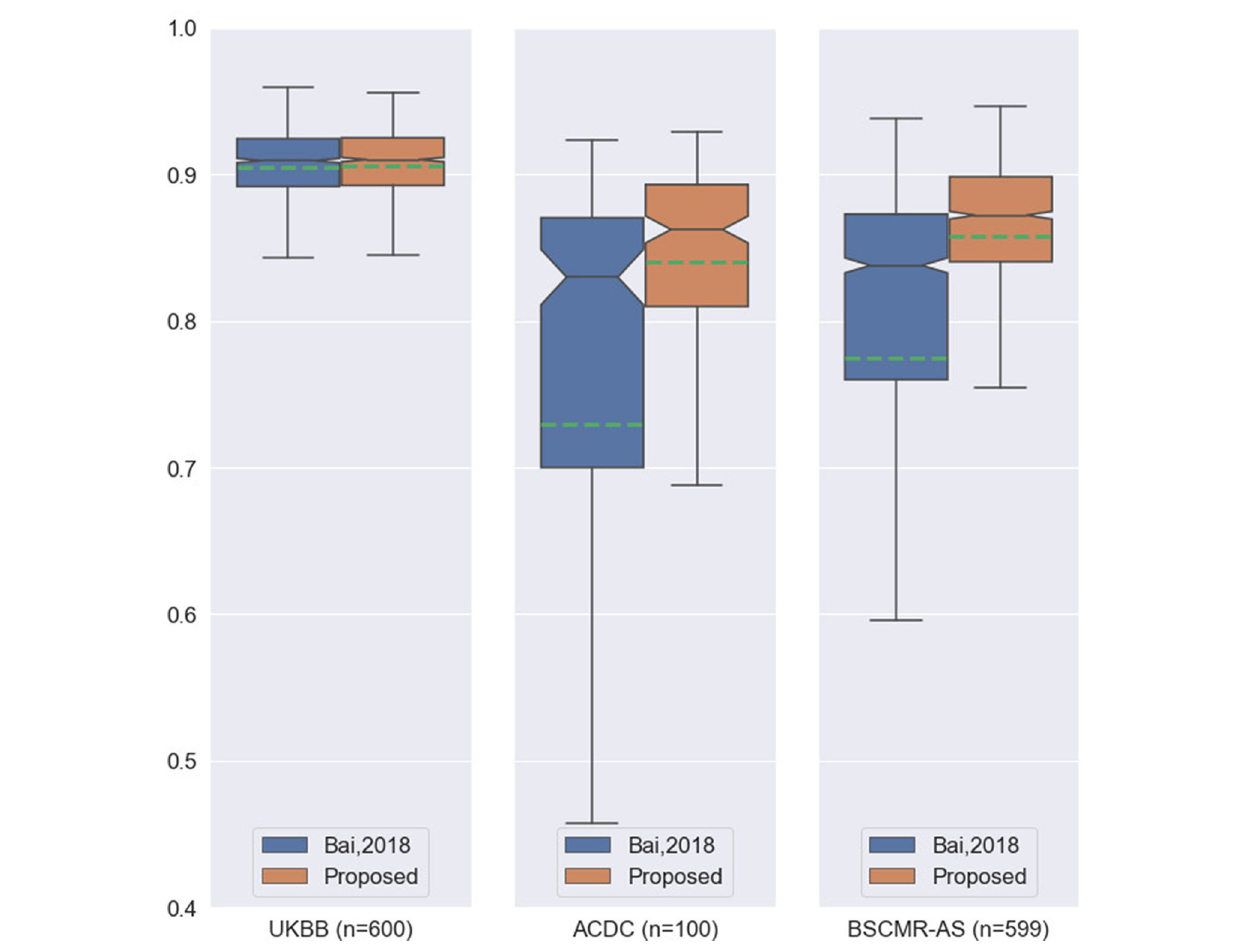
FIGURE 2 | Boxplots of the average Dice scores between the results of our previous work (3) and the results of the proposed method on the three datasets. For simplicity, we calculate the average Dice score over the three structures (LV, MYO, RV) for each image in the three datasets. The boxplots in orange are the results of the proposed method whereas the boxplots in blue are the results of the previous work. The green dashed line in each boxplot shows the mean value of the Dice scores for the segmentation results on one